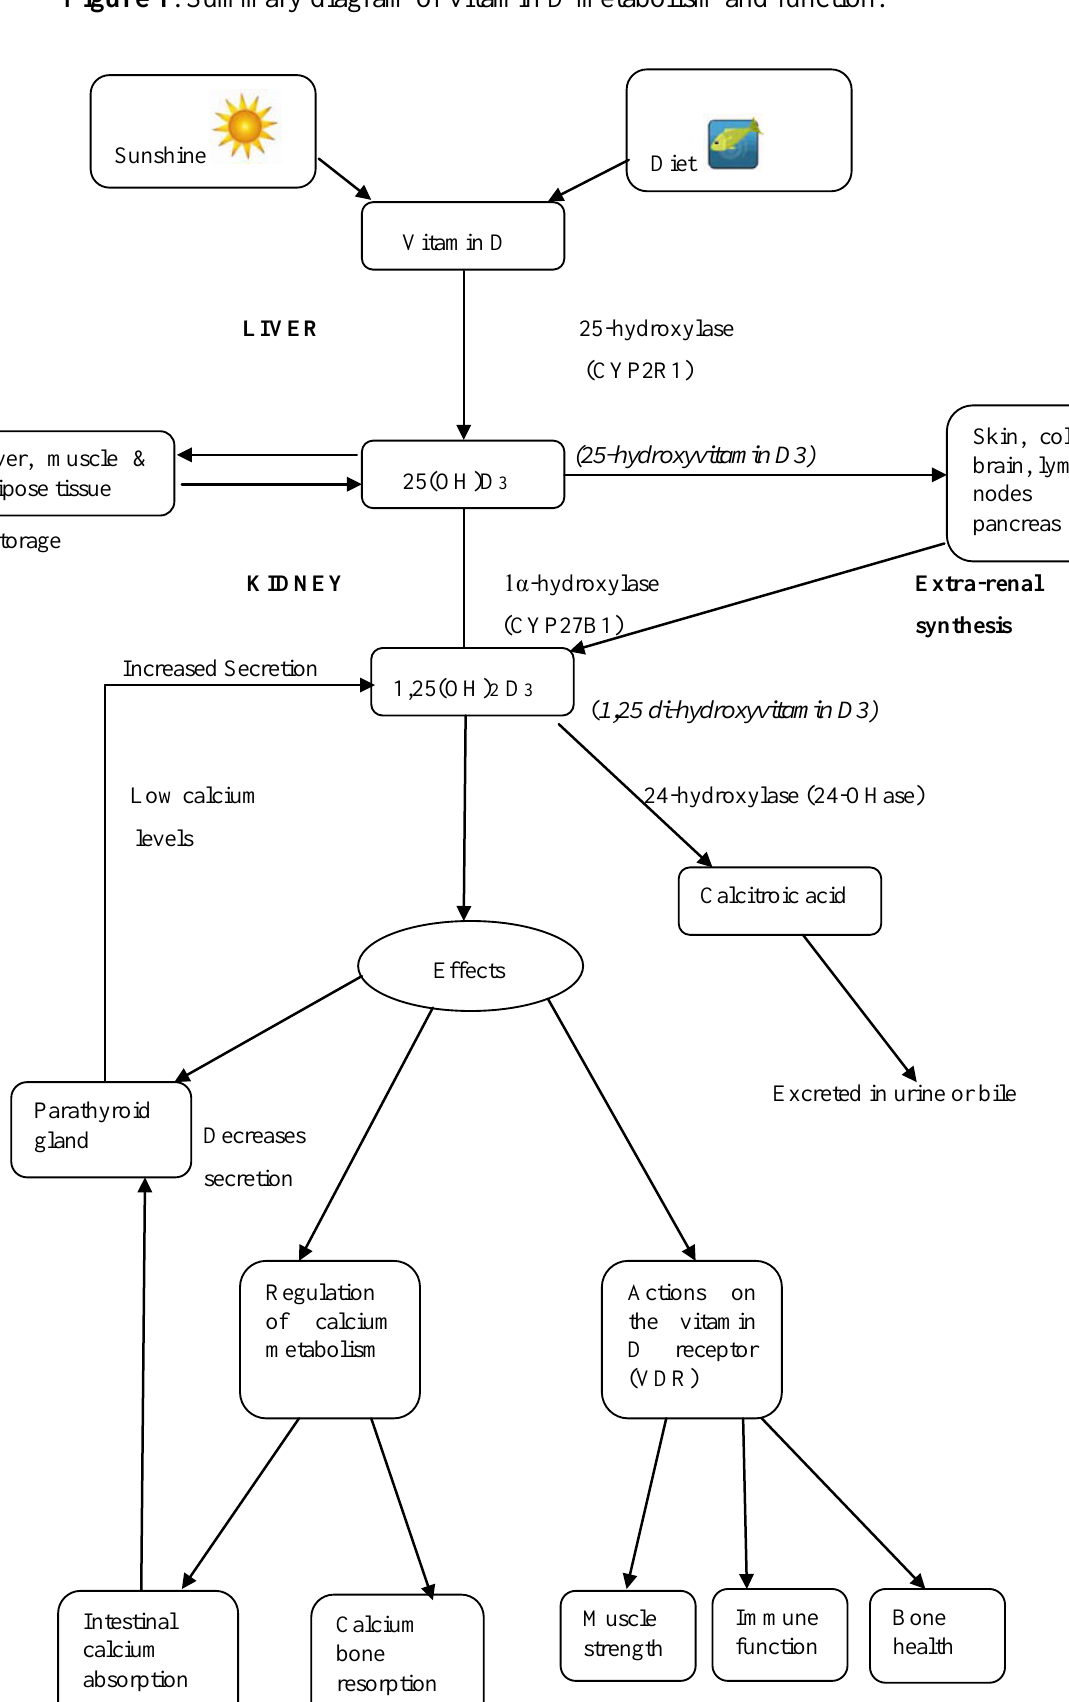
Figure 1 . Summary diagram of vitamin D metabolism and